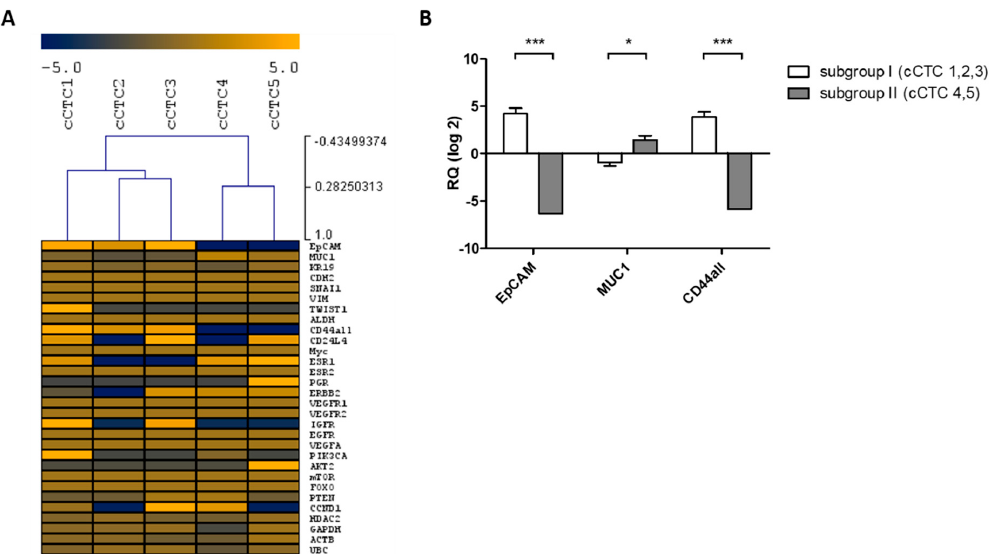
Figure 5. Gene expression of single cultured CTCs. ( A ) Dendrogram and heat map analyses of Cq measurements of single cCTCs ( n = 5). Each gene is measured in triplicate. Data are mean centered, with mean expression responses to zero. Yellow indicates high expression and blue color represents downregulation relative to the mean of the pool. ( B ) Bar graph showing significant differences in transcript expression between subgroup I (cCTC 1, 2, 3) and subgroup II (cCTC 4, 5) (* p < 0.05, *** p < 0.001).